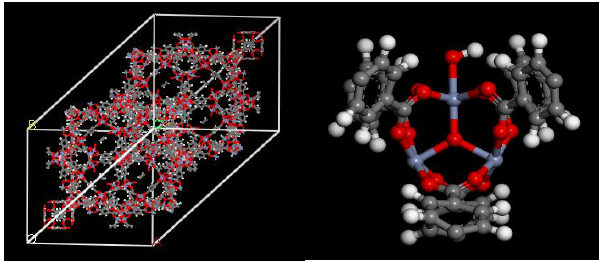
Figure 1. Structures of the MIL-101 (Cr) crystal and